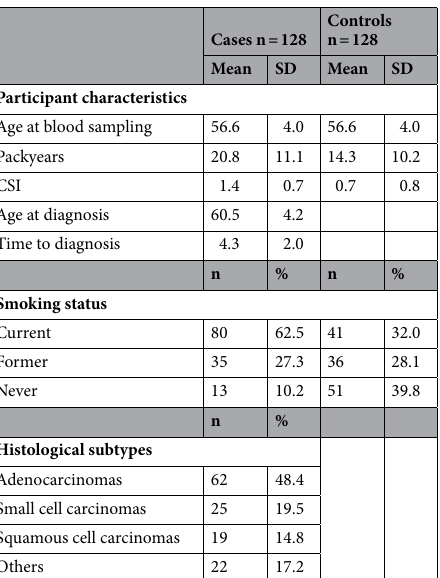
Table 1. Characteristics of the NOWAC participants. SD standard deviation, CSI Cumulative smoking intensity.